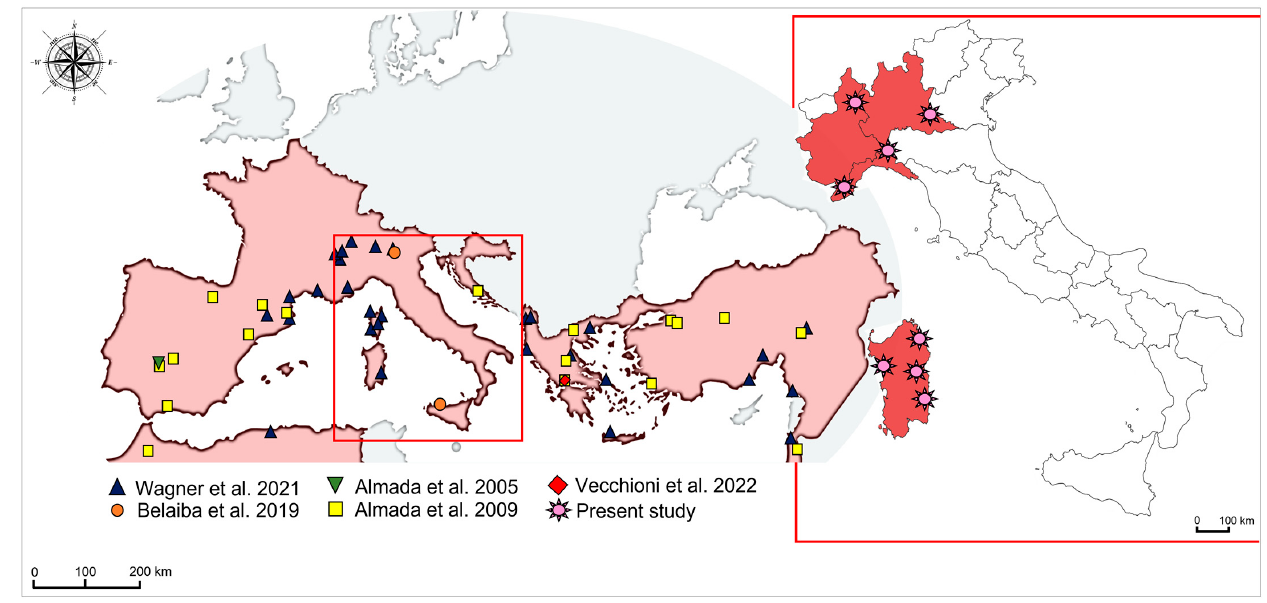
Figure 1. Map of samples’ collection sites. The map shows the geographical origin of the sequences isolated in the present study along with those from previous research [1,8,15,16,24].